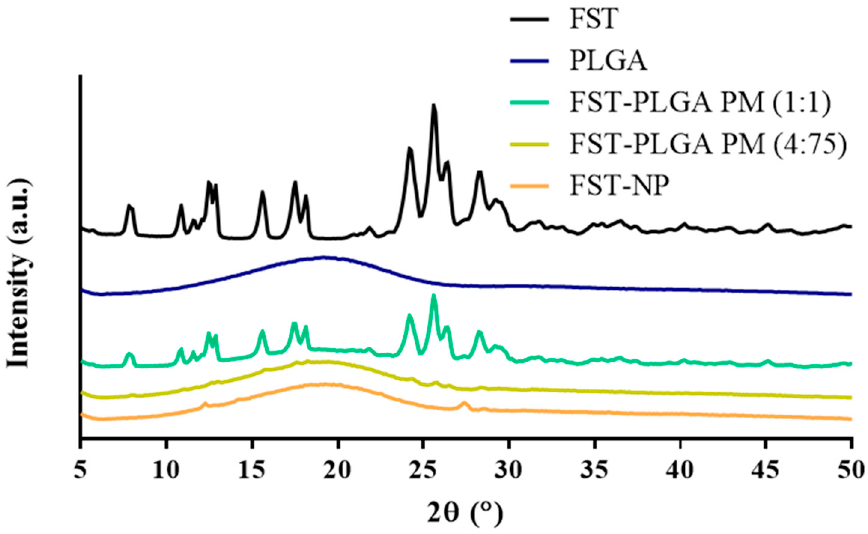
Figure 6. PXRD pattern of FST, blank PLGA nanoparticles, physical mixture 1:1, physical mixture 4:75, and FST–NP.